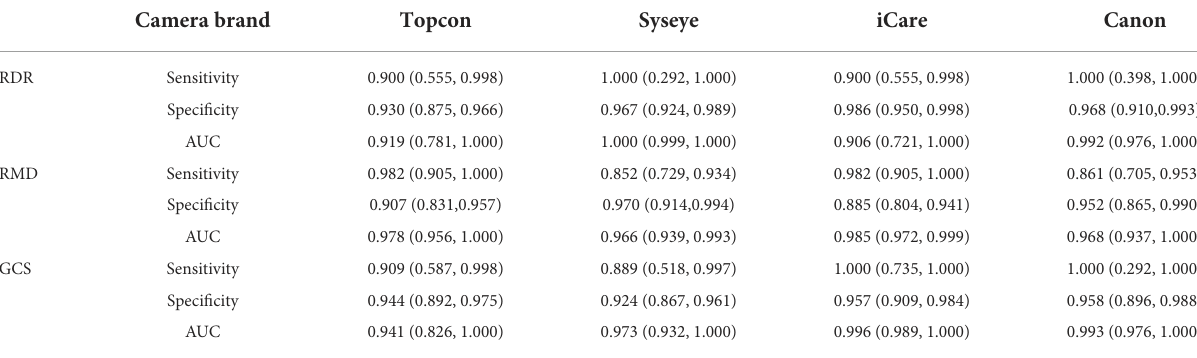
TABLE 5 Prediction performance of AI-100 on RDR, RMD, and GCS across cameras.